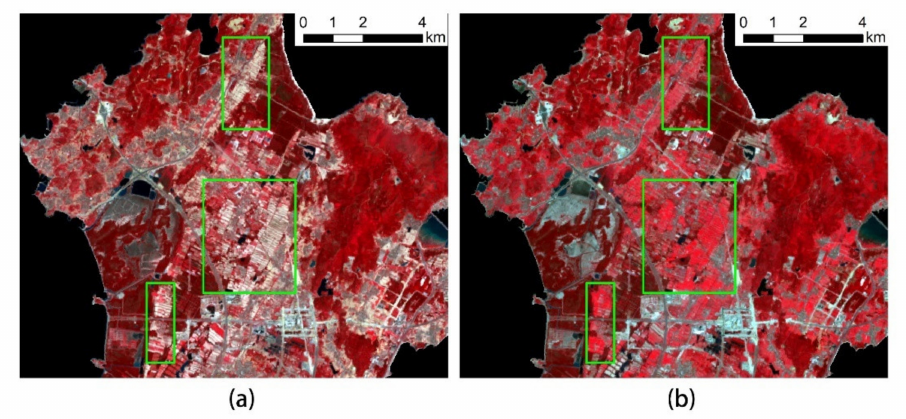
Figure 8. Cultivated land in the north and west of Haitan Island: ( a ) fallow season, Landsat image obtained in April 2020, ( b ) growing season, Landsat image obtained in June 2020 (subset of Landsat 8 OLI, shown with band 5, 4, and 3 in red, green, and